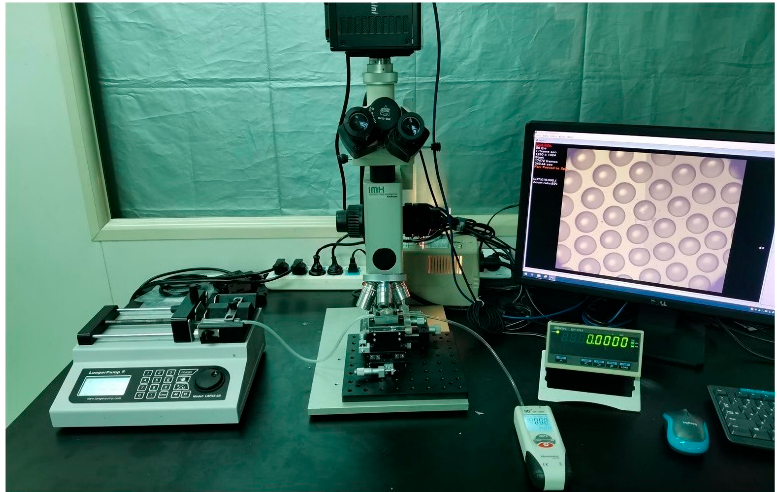
Figure 3. Three-dimensional diagram of the home-built metal mold structure: ( a ) grooved tray for relieving excess pressure in the hot embossing process; ( b ) sealed cavity for package of the PDMS intermediate die with MLA structure.